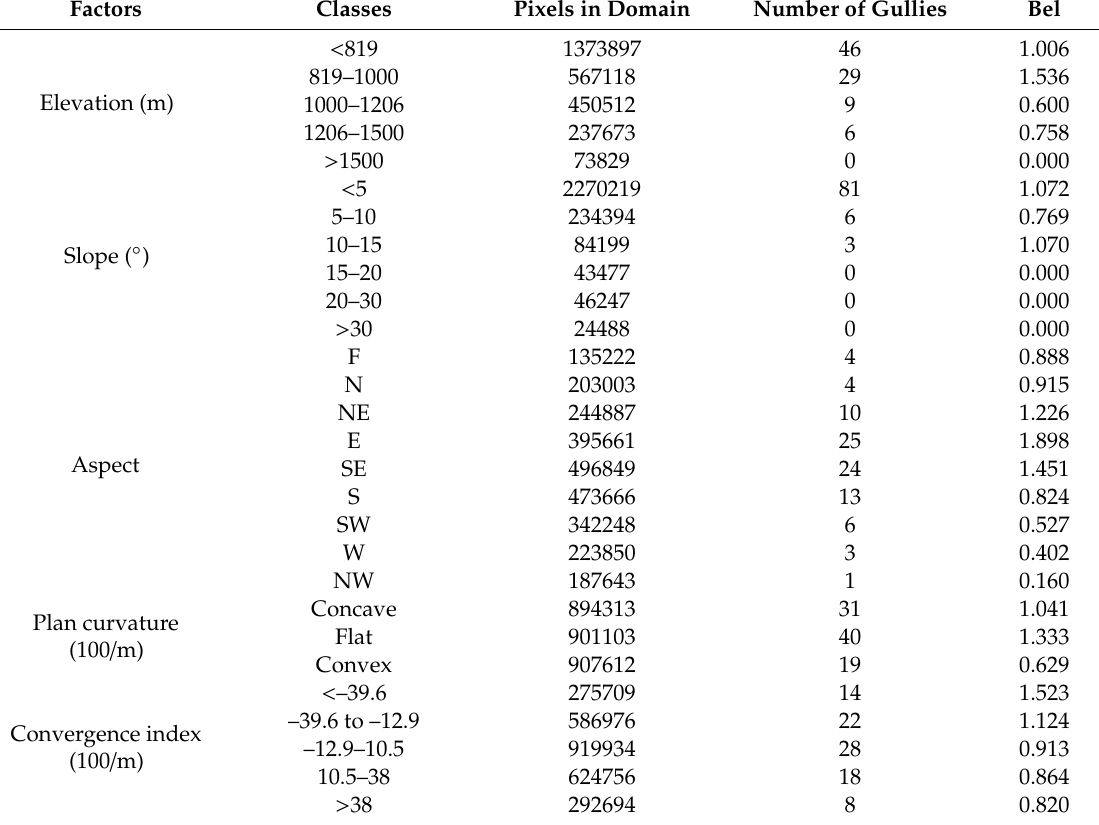
Table 4. Spatial Analysis of Gully Erosion Conditioning Factors and Gully Locations using the Evidential Belief Function (EBF)